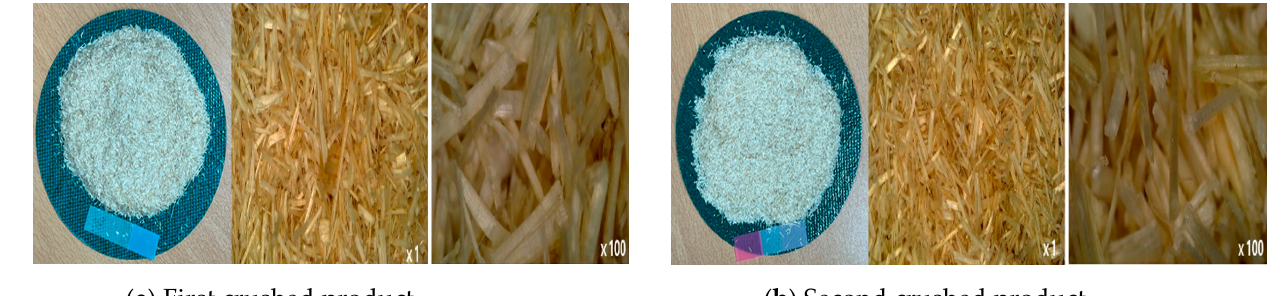
Figure 12. Images of cleaned and crushed Kenaf fibers after surface treatment.